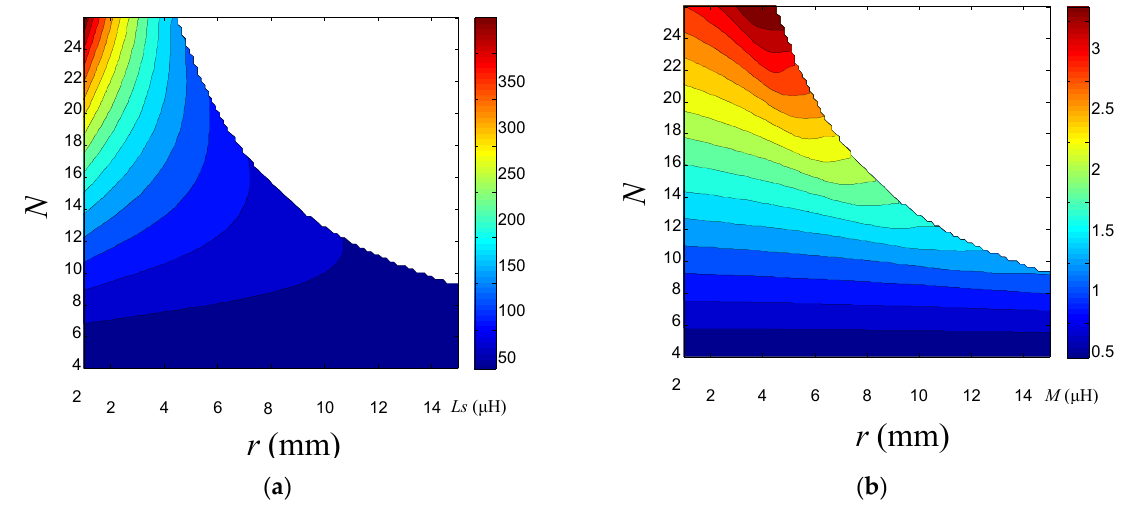
Figure 9. Calculated value of L S and M with variable N and r . ( a ) N - r - L S ; ( b ) N - r - M .